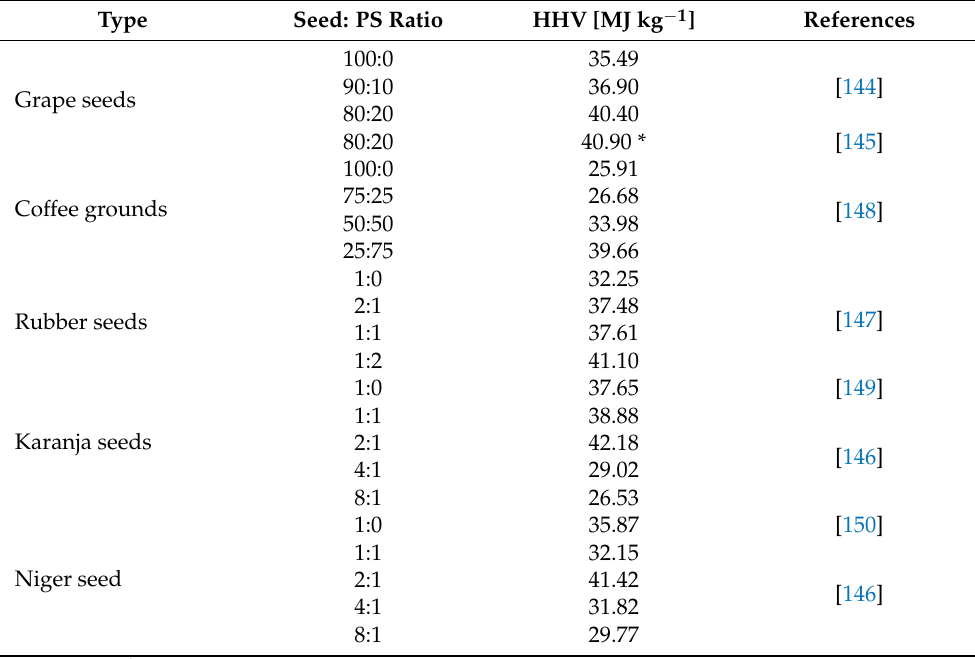
Table 4. Energy content of co-pyrolysis of PS and biomass